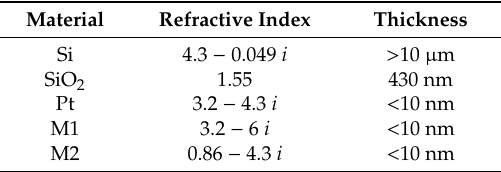
Table 1. The optical constants for di ff erent compositional materials used in triple layer systems with 100% anti-reflection. M1 and M2 refer to artificial materials. M2 has optical constants similar to many metals. The values were obtained for incident wavelength of λ = 500